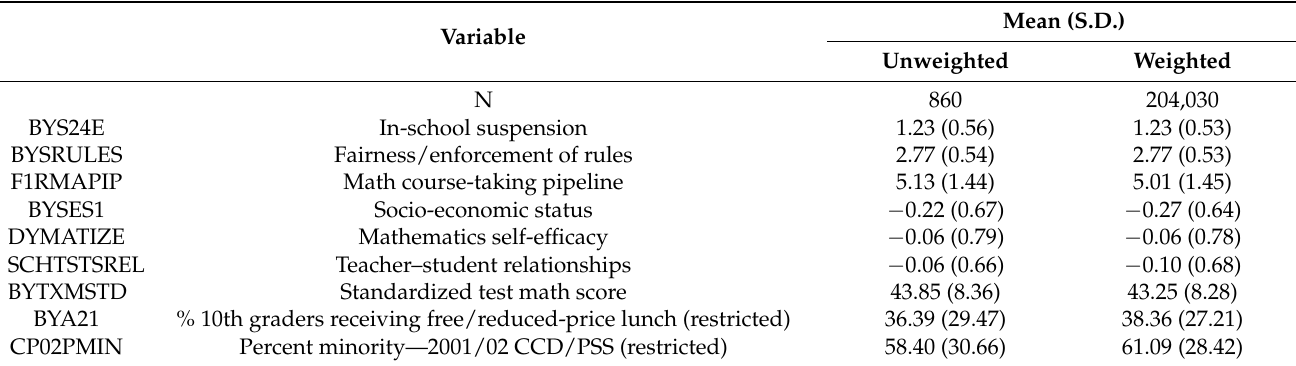
Table 2. Means and standard deviations.